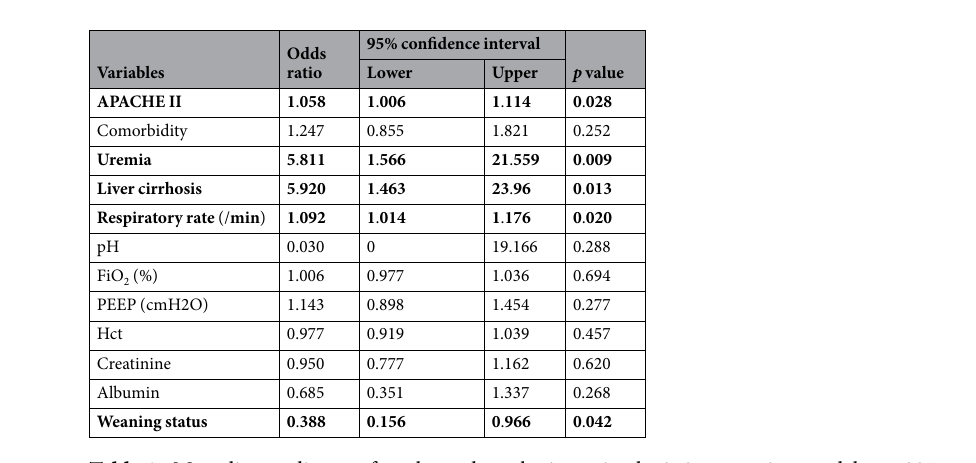
Table 4. Mortality predictors of unplanned extubation using logistic regression model. n =